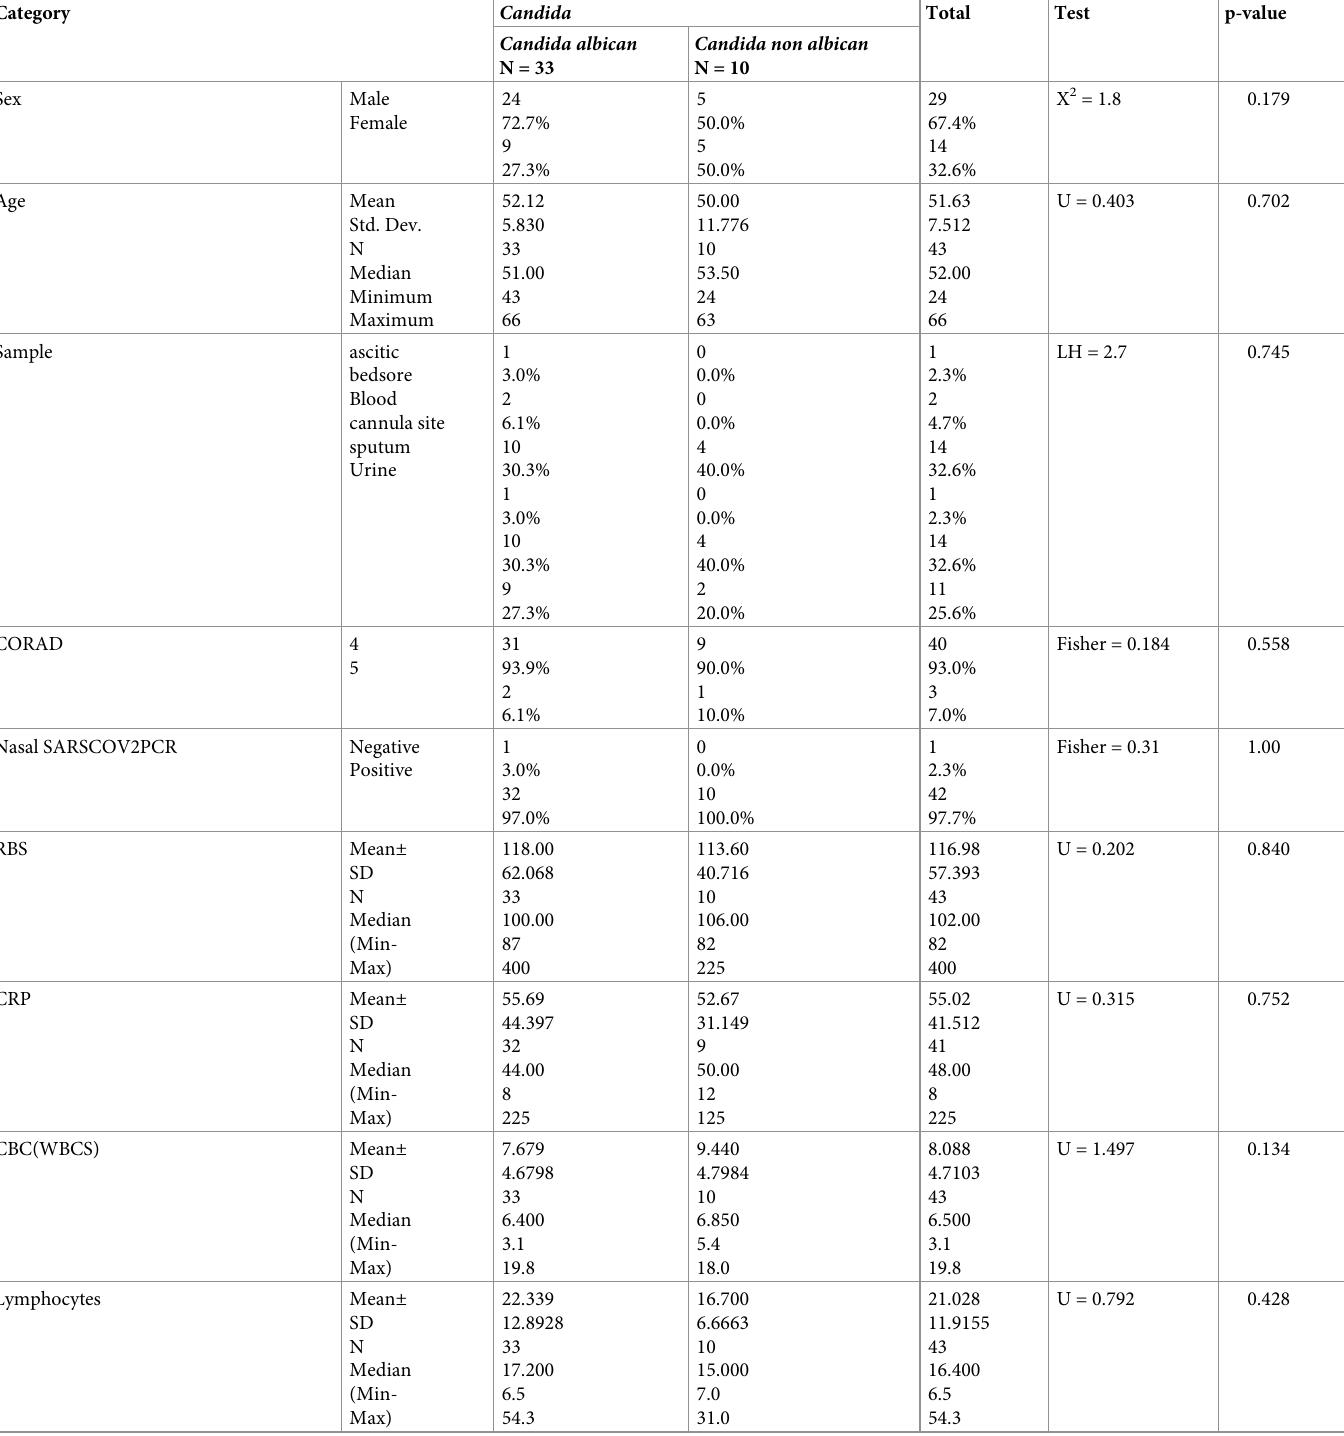
Table 3. The sociodemographic, laboratory, antifungal sensitivity, virulence factors in Candida albicans versus Candida non-albicans isolates. Category